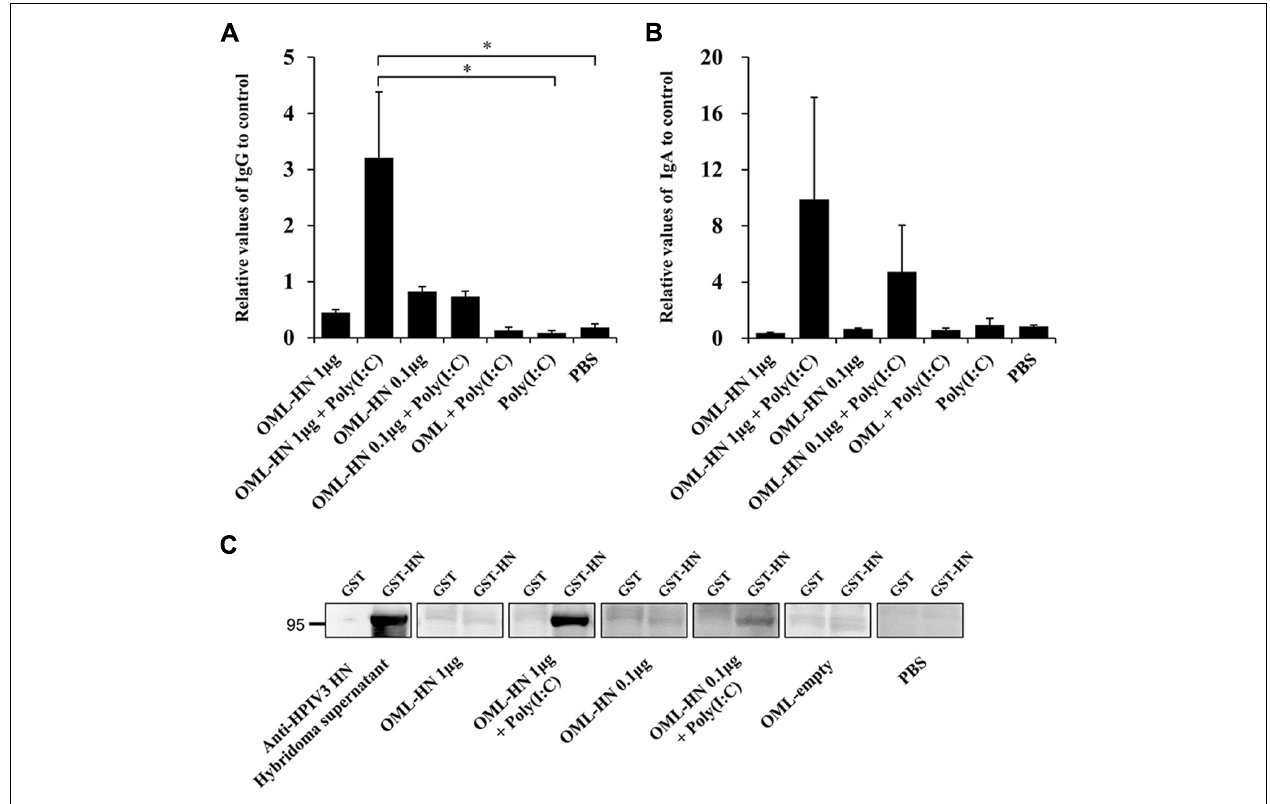
immunization were determined by ELISA. Each bar represents the mean ± SE ( t test: * P < 0.05). (C) Immunoblot analysis of recombinant HN proteins in mouse sera. Recombinant GST or GST-HN proteins were subjected to SDS-PAGE followed by the immunoblotting with the indicated serum.